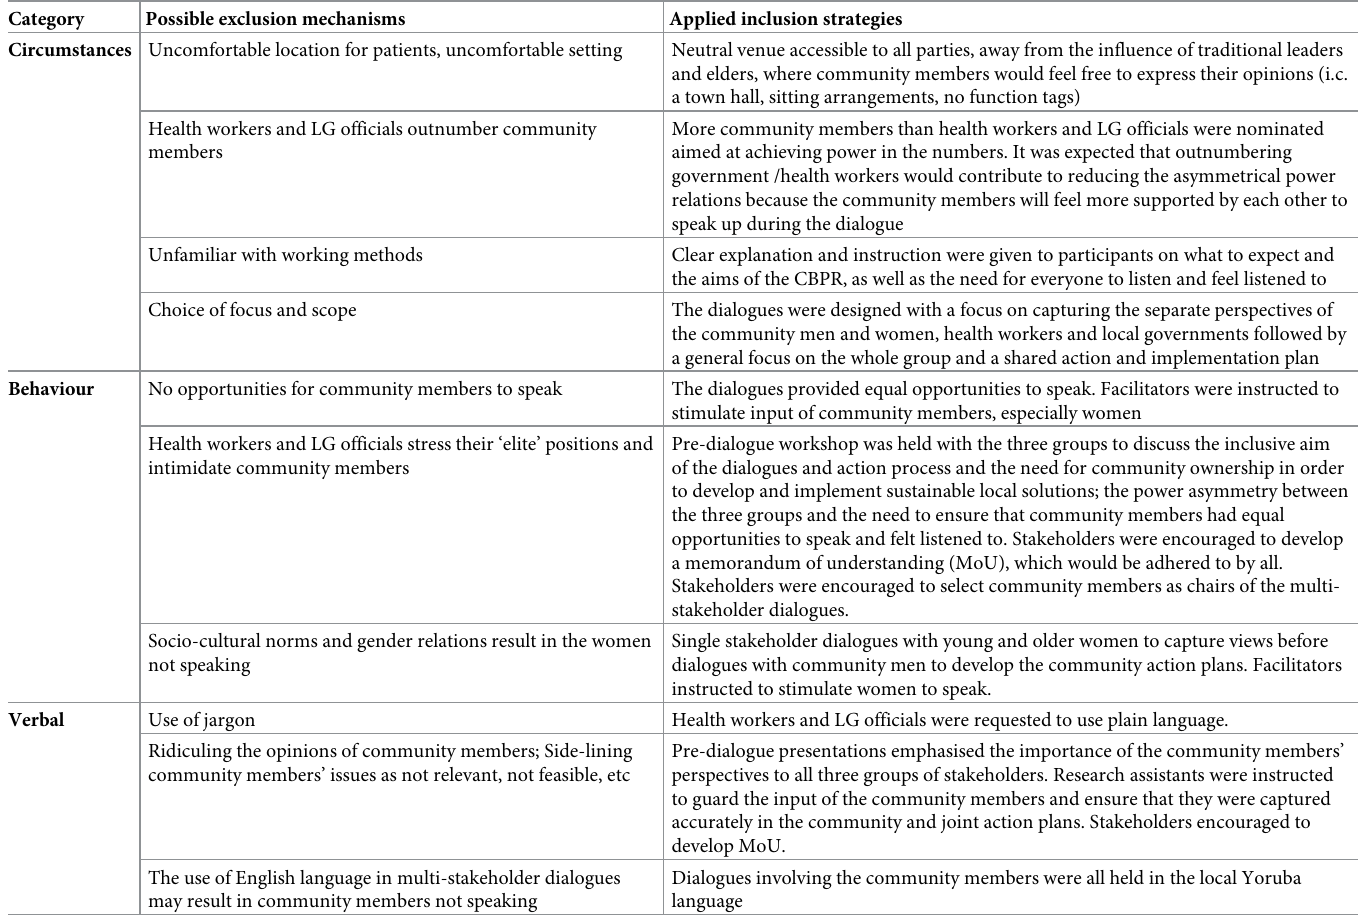
Table 1. Possible exclusion mechanisms and the inclusion strategies used in the dialogues of the CBPR